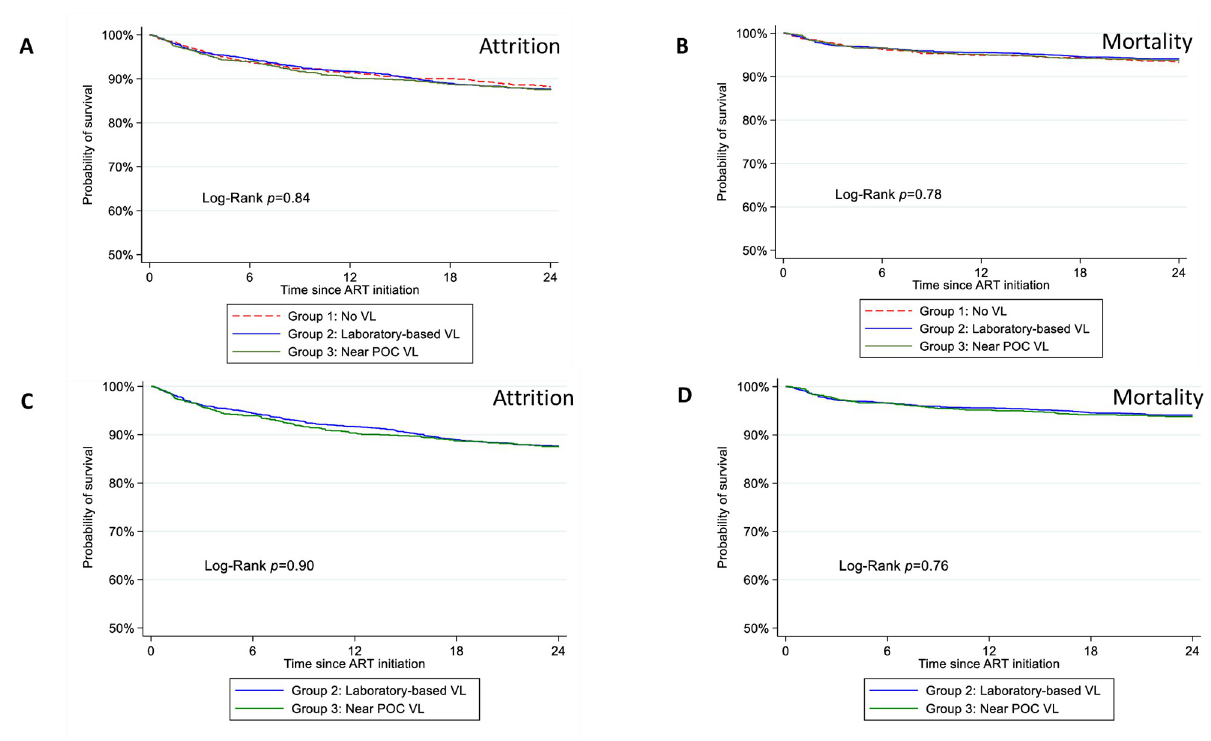
Fig 2. Comparing outcomes on ART among PLHIV with different access to VL testing. Panel A, C present two-year attrition (dead, lost-to-follow- up) and panel B, D two-year mortality between PLHIV on ART who when becoming eligible had no access to VL testing (Group 1: No VL), access to laboratory-based VL testing (Group 2: Laboratory-based VL) or access to near POC VL testing (Group 3: Near POC VL). Panels A and B include all three groups while Panels C and D only. compare Groups 2 and 3. ART = antiretroviral therapy, PLHIV = people living with HIV/AIDS, POC = point of care, VL = viral load.